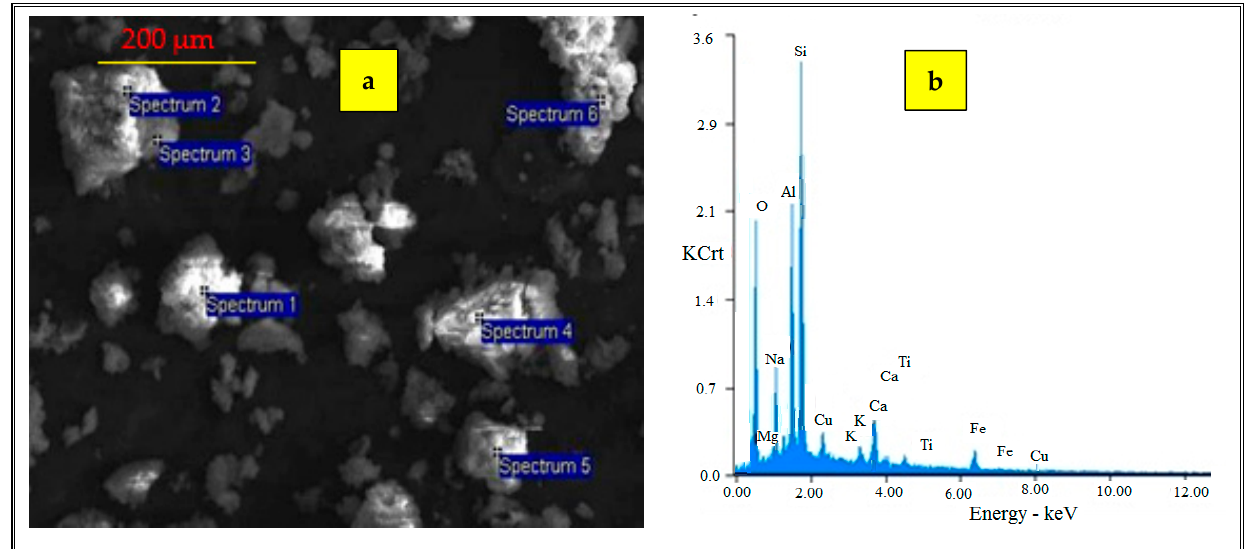
Figure 7. EDX analysis ( a ) after Cu 2+ adsorption ( b ).